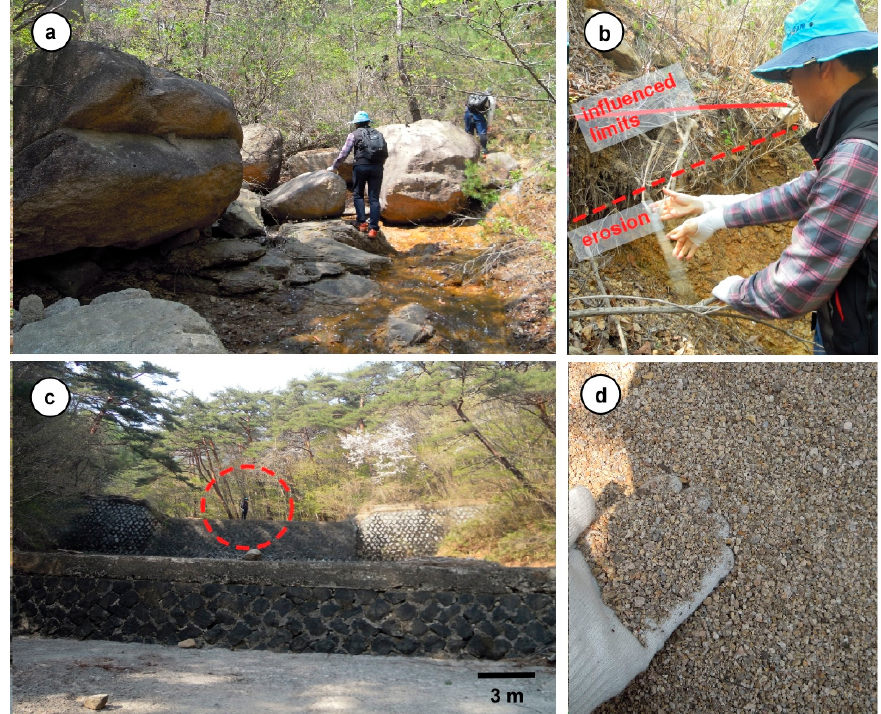
Figure 2. Site survey and regional characteristics in the study area: ( a ) main channel, ( b ) erosion, ( c ) check dam (with a man denoted by a dashed circle to provide scale), and ( d ) deposition of sediments at the bottom of the basin.